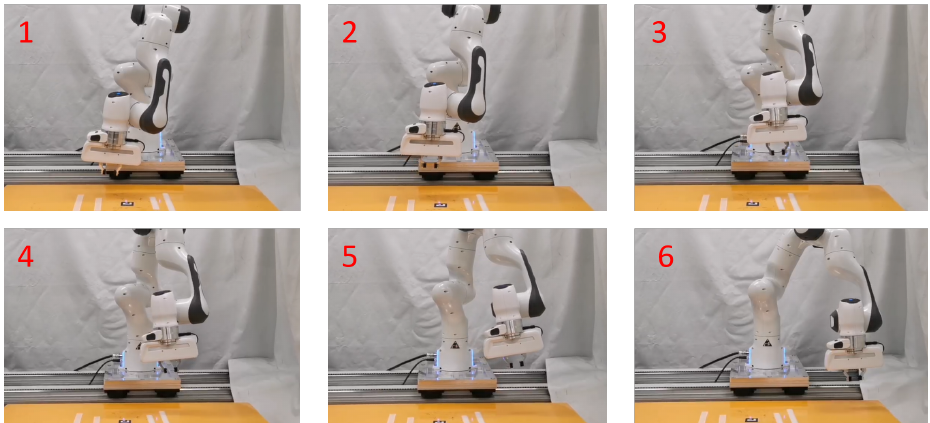
Figure 10. Trajectory reproduction experiment.